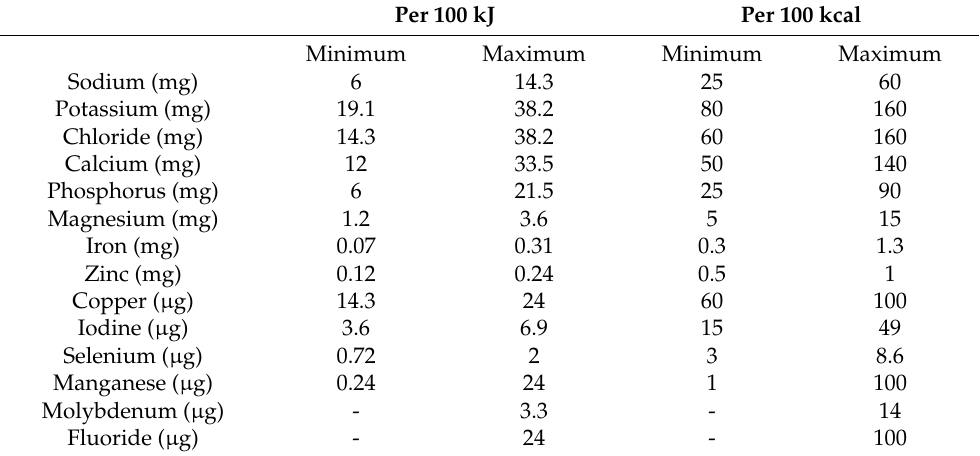
Table 4. Mineral requirements for infant formula manufactured from bovine milk protein, caprine milk protein or protein hydrolysates [14]. Per 100